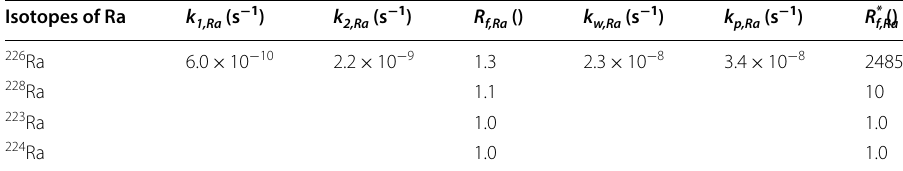
Table 12 Model-derived rate constants of adsorption ( k ( k ) and precipitation ( k w to sorption processes and ( R f* ) due to sorption processes as well as co-precipitation Isotopes of